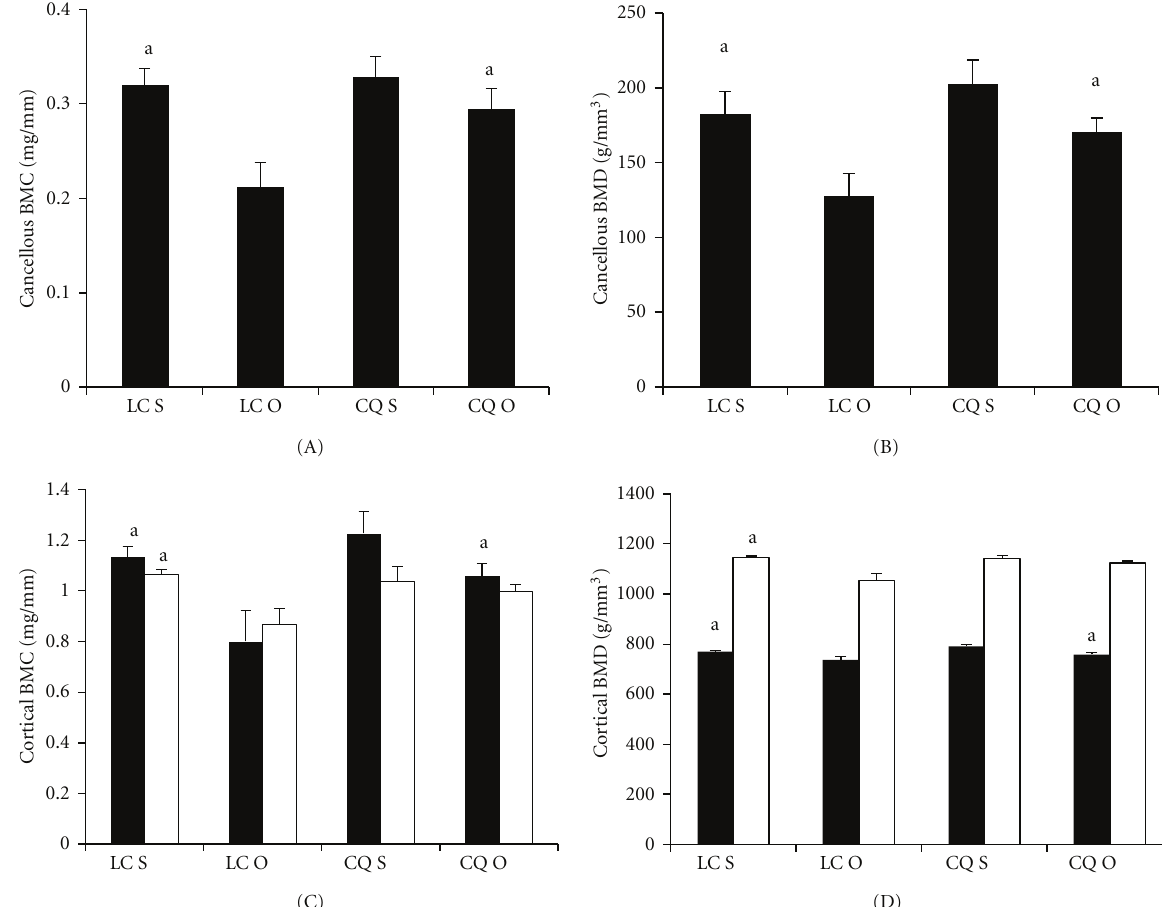
Figure 1: E ff ects of Cissus quadrangularis on the cancellous and cortical bone parameters of the distal femoral metaphysis and femoral diaphysis of C57Bl/6 mice after ovariectomy using pQCT. Data are Mean ± SE. (A) cancellous BMC; (B) cancellous BMD; (C) cortical BMC; (D); Cortical BMD. Black bars represent distal femoral metaphysis; white bars represent femoral diaphysis. LC S:lab chow sham; LC O: lab chow ovariectomy; CQ S: Cissus quadrangularis sham; CQ O: Cissus quadrangularis ovariectomy. a P < 0 . 05 versus LC